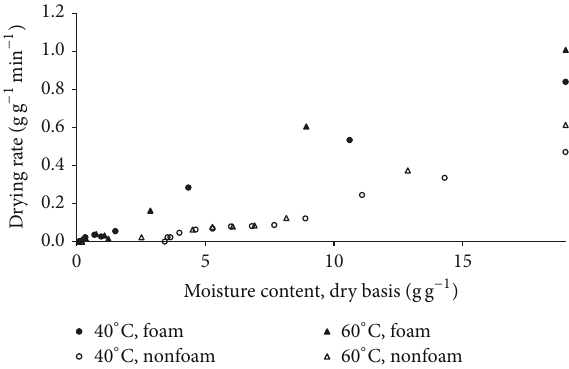
Figure 3: Drying rate of foam and nonfoam roselle extract drying at different air